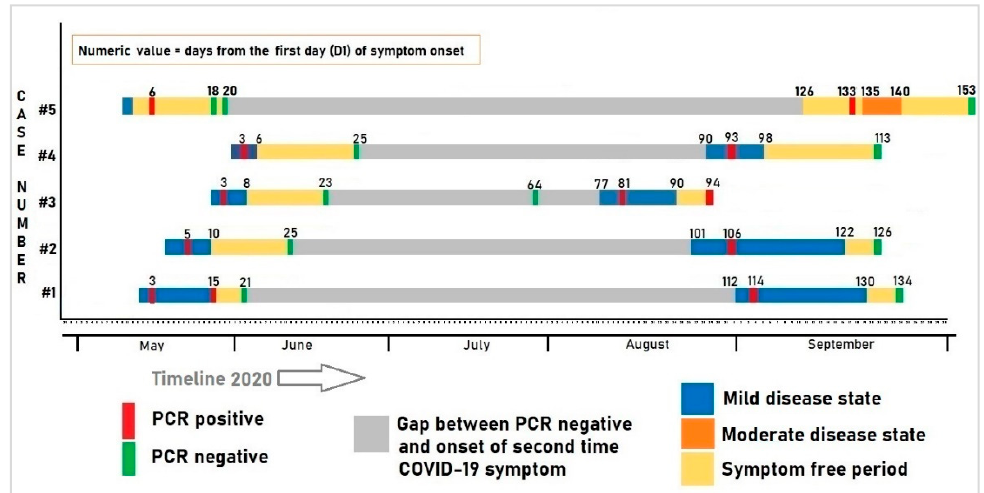
Figure 1. Clinical course and the corresponding PCR test results of the five patients with recurrent episodes of COVID-19 infection.